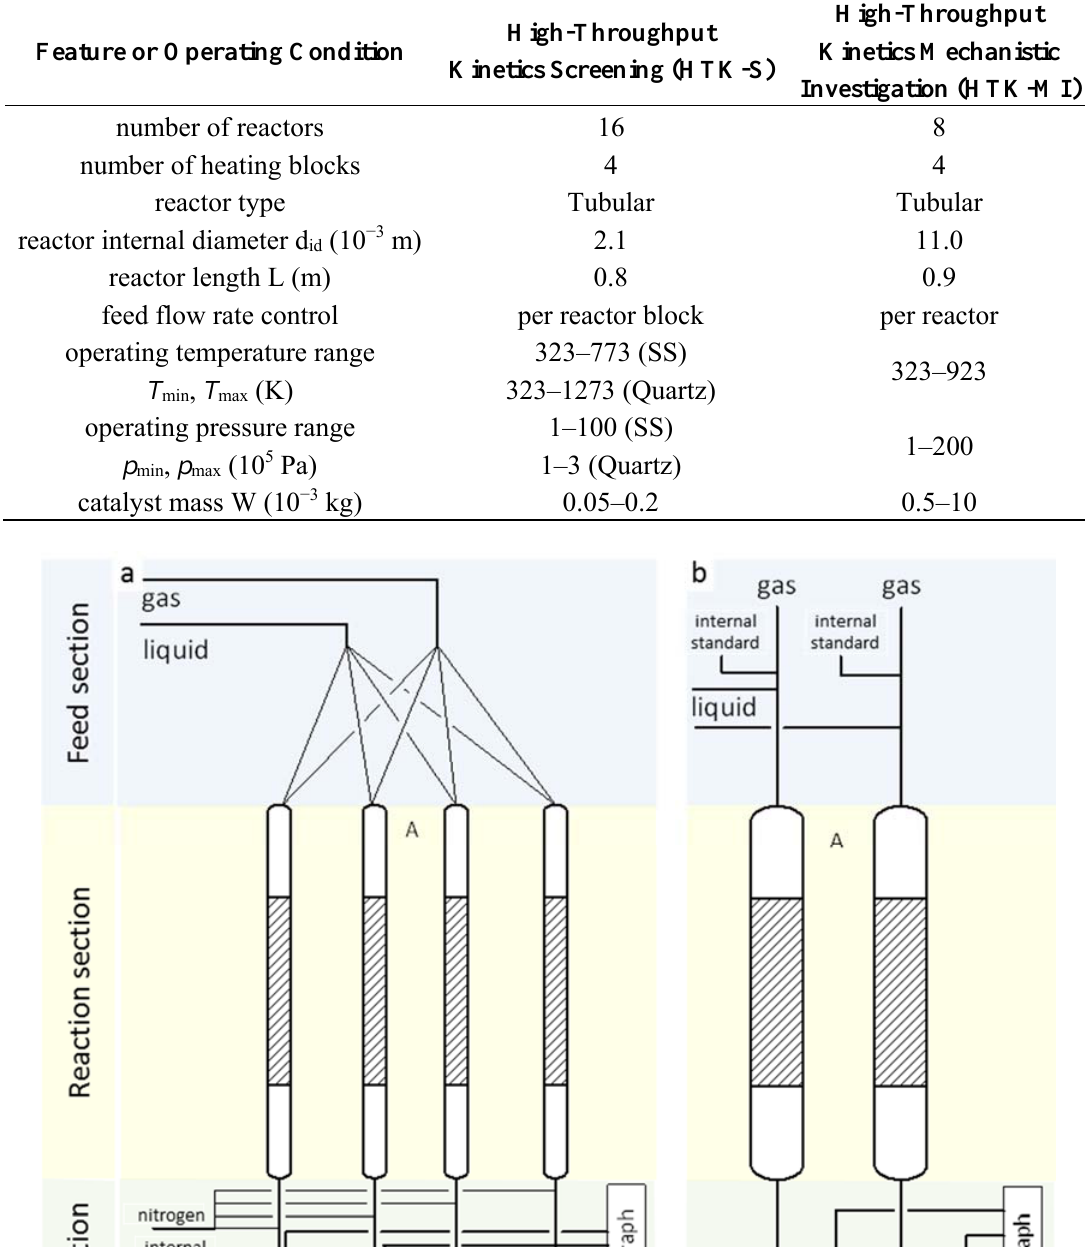
Table 1. Features of and operating conditions used in the set-ups for Information-driven catalyst design.